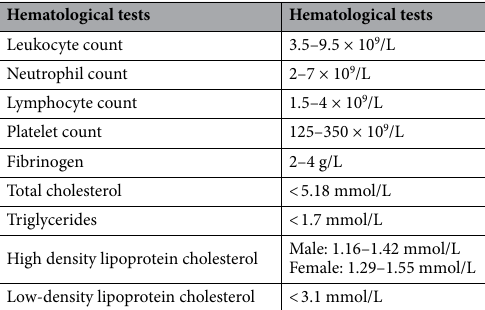
Table 1. Normal reference values of blood test